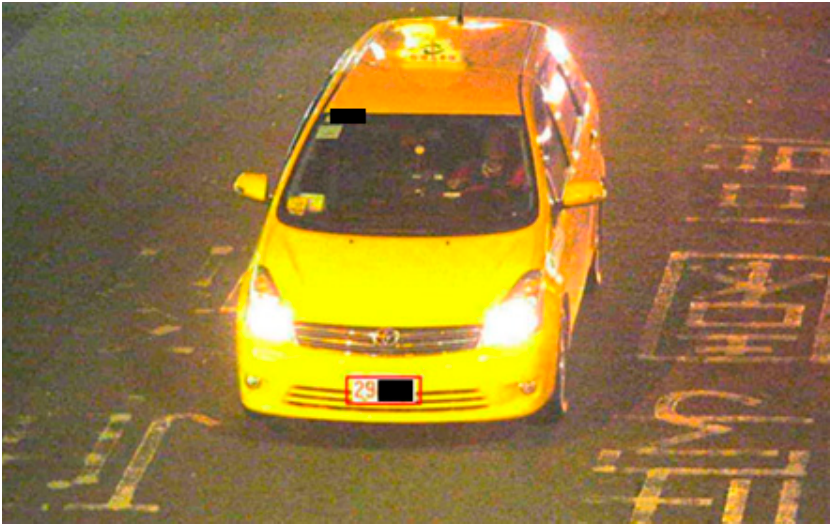
Figure 6. A schematic diagram for detecting the identification of special case of vehicle.